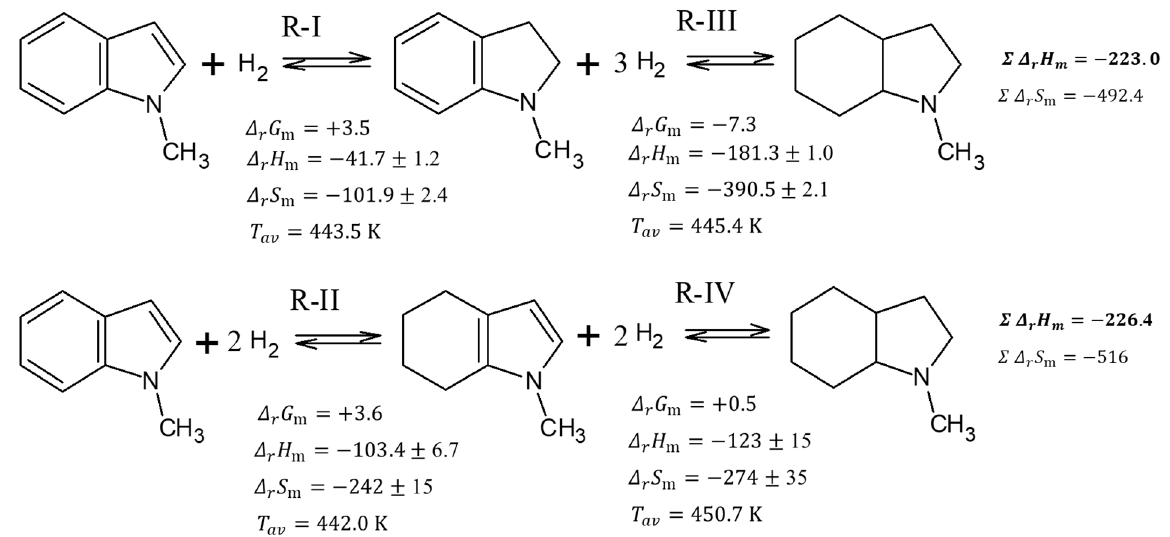
Figure 5. Total thermodynamic analysis of conversions in the system 1-methyl-indole/octahydro-1-